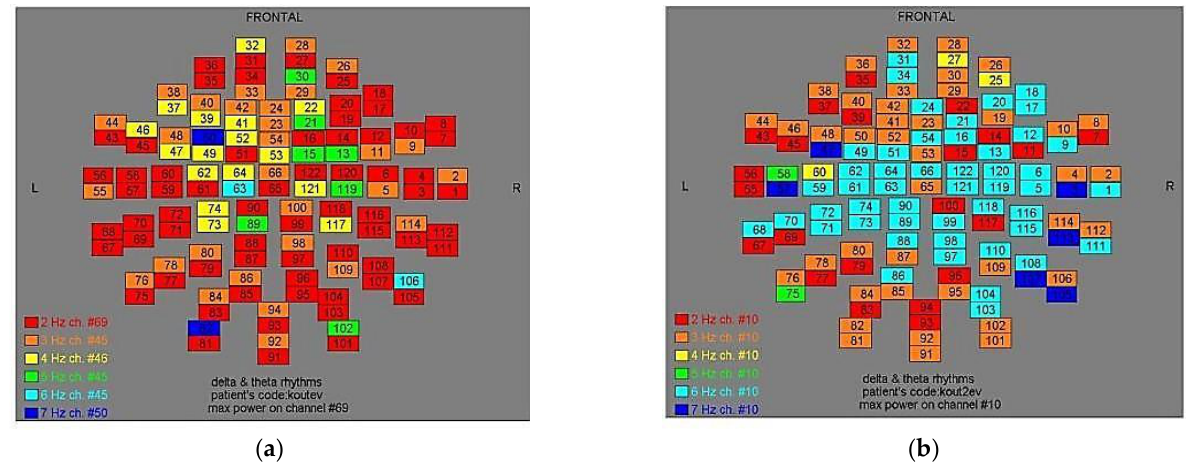
Figure 4. Dominant frequency color mapping for patient #3, before ( a ) and after ( b ) magnetic stimulation.